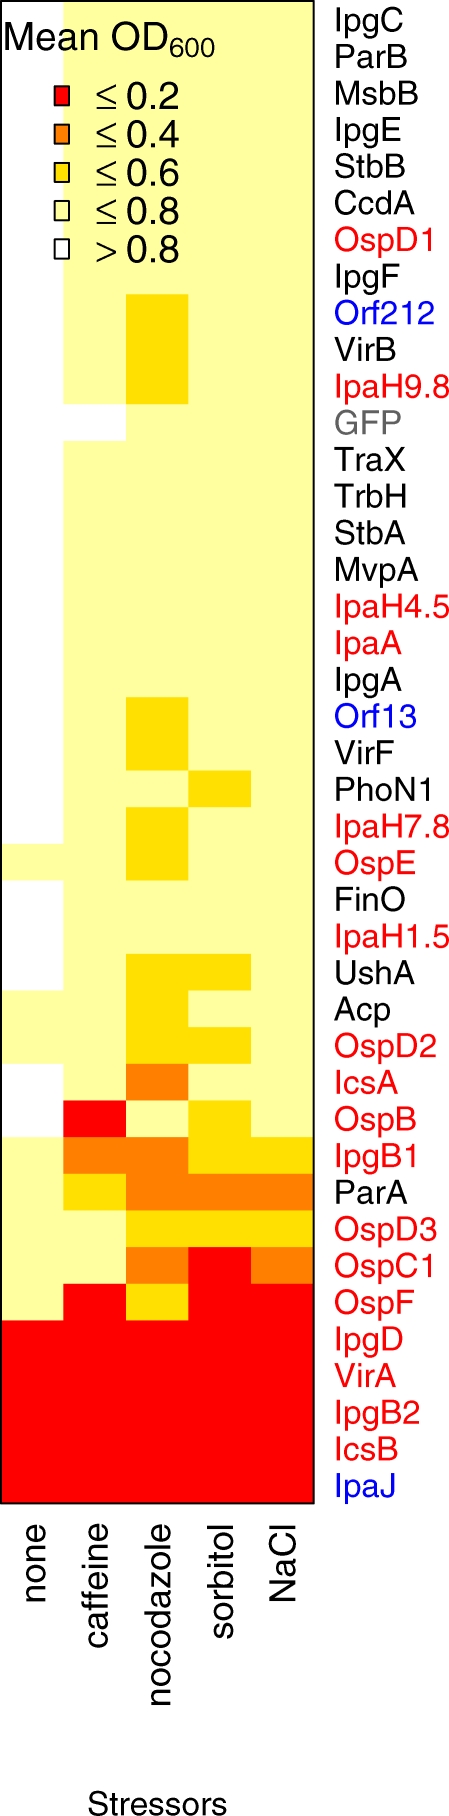
The Addition of Stressors Elicits Additional Yeast Growth Inhibition Phenotypes by Translocated ProteinsThe heatmap summarizes the relative growth at t = 48 h of yeast that express the Shigella GFP fusion proteins or GFP grown under each of five conditions: no stressor, 6 mM caffeine, 3 μg/ml nocodazole, 0.5 M sorbitol, and 0.5M NaCl. Each cell represents the mean OD600 measurements at 48 h of six independent yeast colonies expressing the same bacterial protein from a low-copy yeast expression plasmid grown under the same condition. Rows and columns were clustered by the complete linkage algorithm using the standard Euclidean distance metric operating directly on data vectors (i.e., without normalization). The proteins labeled in red are translocated, those labeled in black are non-translocated, and the unknowns in blue. GFP control is labeled in gray.